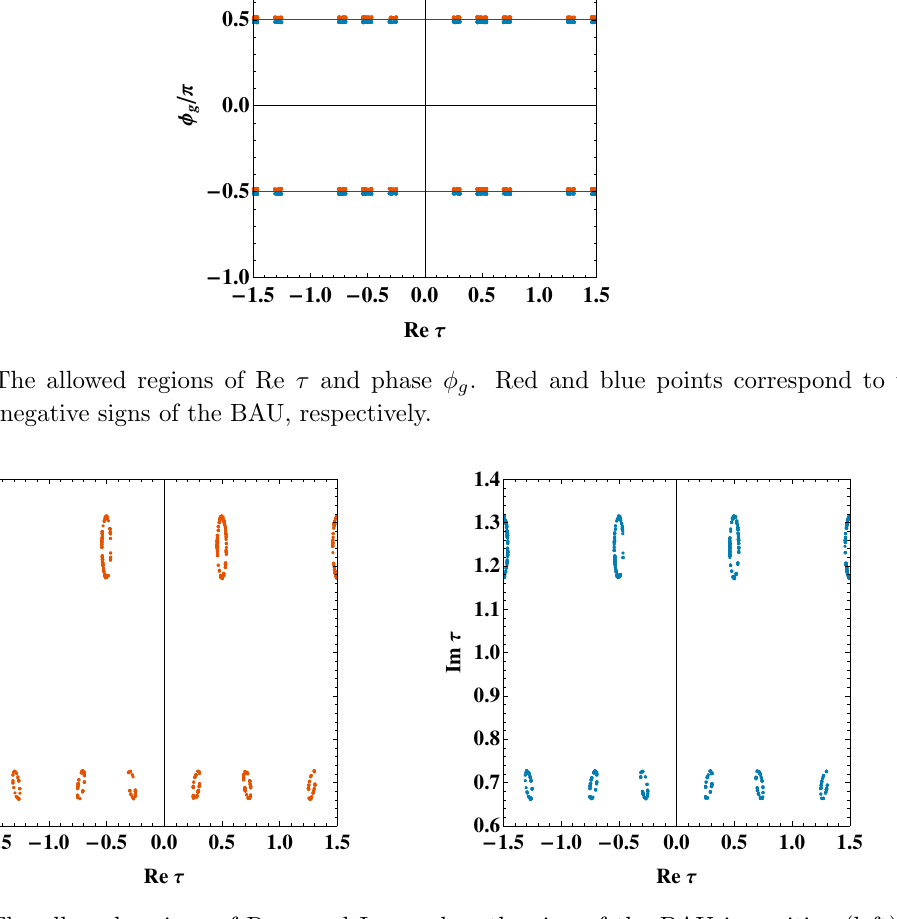
Figure 5 . The allowed regions of Re (cid:28) and Im (cid:28) when the sign of the BAU is positive (left) or negative